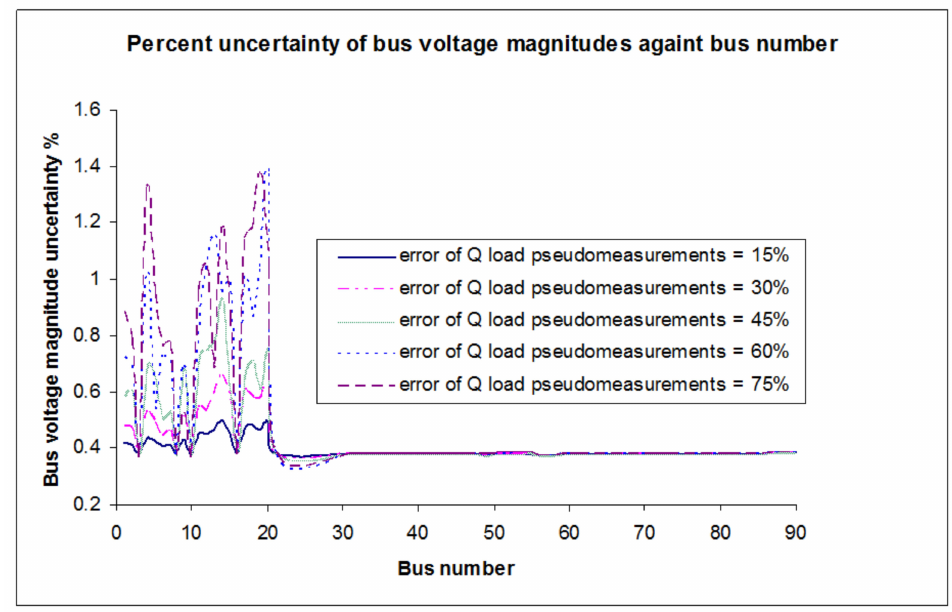
Figure 8. Bus voltage magnitude uncertainties with regard to errors in reactive load pseudo- measurements.